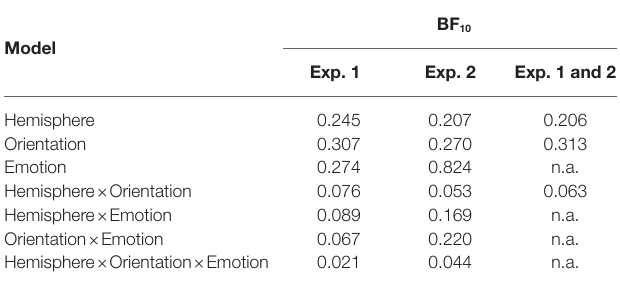
TABLE 2 | Bayes factors (BF 10 ) for main effect and interaction models with mean amplitude differences (N2pc) of Experiments 1 and 2, as well as for the combined analysis of both experiments.